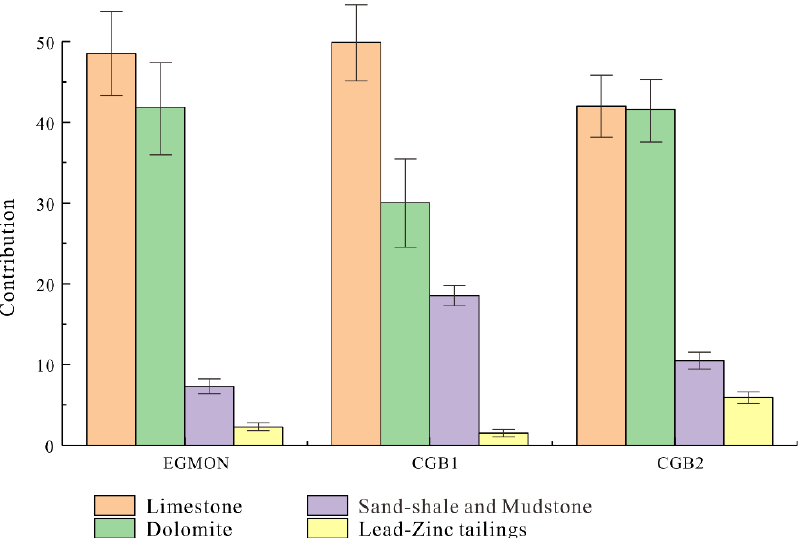
Figure 5. Contributions of each source to the catchment sediment samples collected during the three baseline project periods.